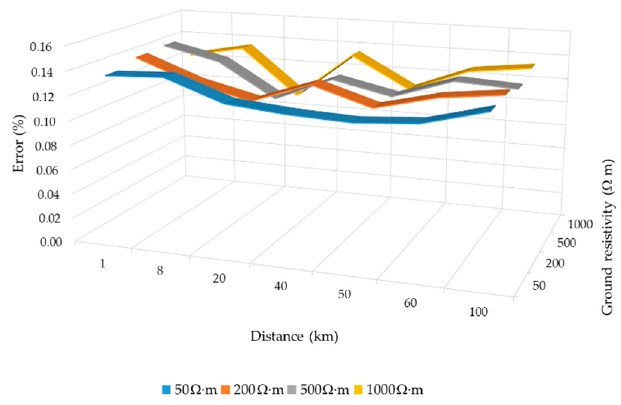
Figure 15. Location error for SLG faults with varying the soil resistivity.